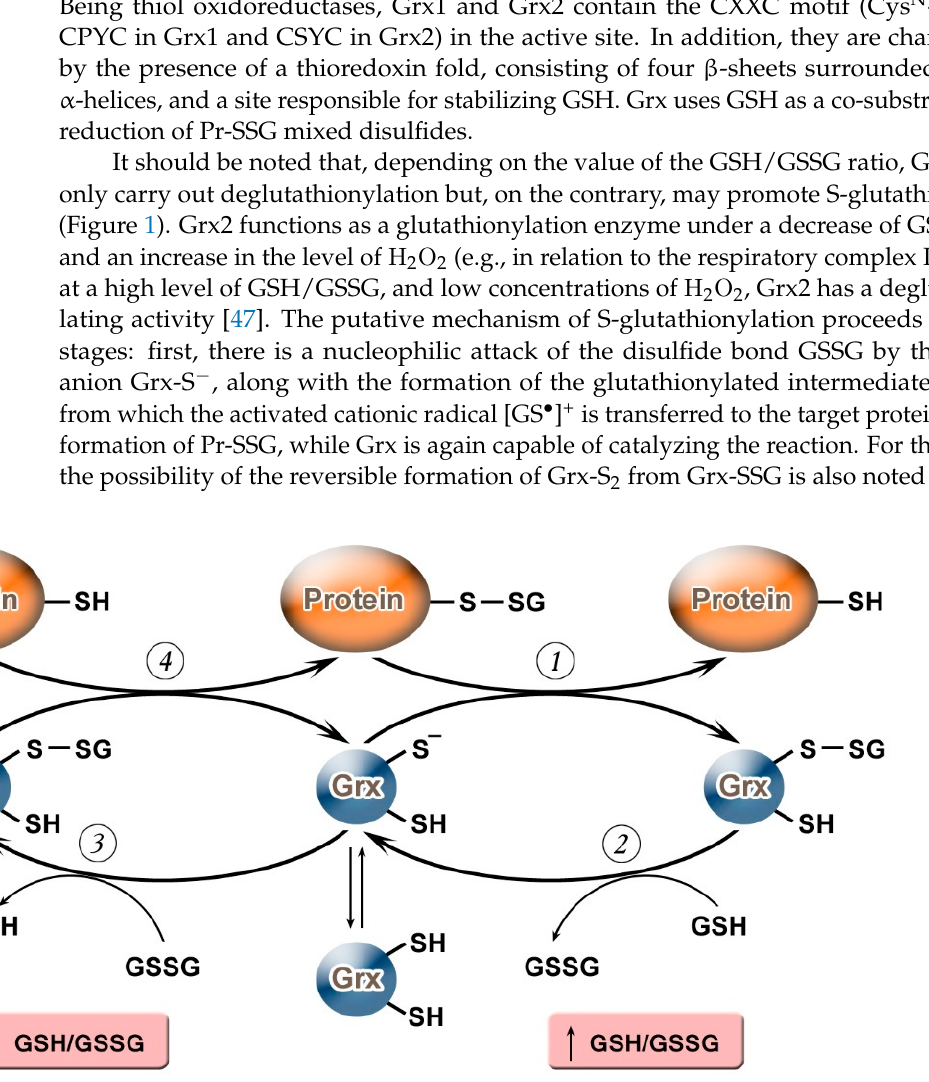
Figure 1. Glutaredoxin catalytic mechanism in dependence of GSH/GSSH ratio. Under an increase in GSH/GSSG, Grx can catalyze the deglutathionylation of proteins. The glutathionylated sulfur moiety of the protein–SSG is attacked by the thiolate anion of the enzyme (Grx-S − ), forming the covalent enzyme intermediate (GRx–SSG) and releasing the reduced protein–SH as the first product (1). The second rate-determining step involves the reduction of Grx–SSG by GSH to produce glutathione disulfide (GSSG) as the second product, recycling the reduced enzyme (Grx–S − ) (2). Under conditions of decreased GSH/GSSG ratio, Grx can catalyze S-glutathionylation of proteins. The S-glutathionylated Grx (Grx–SSG), formed in reaction with GSSG (3), reacts with a protein to create S-glutathionylated protein (protein–SSG) (4).